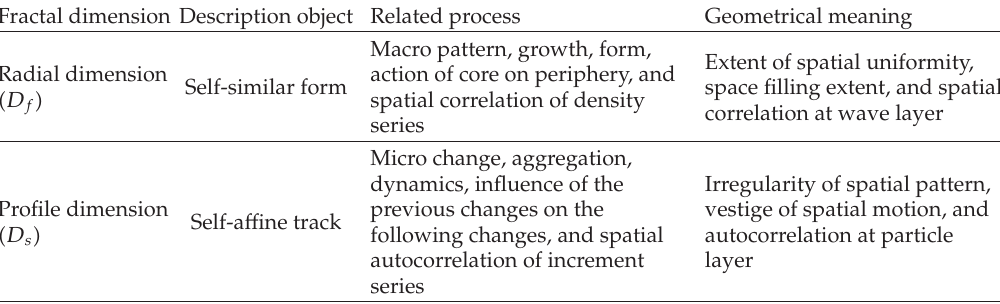
Table 6: Comparison between the radial and profile dimensions. Fractal dimension Description object Related process Geometrical